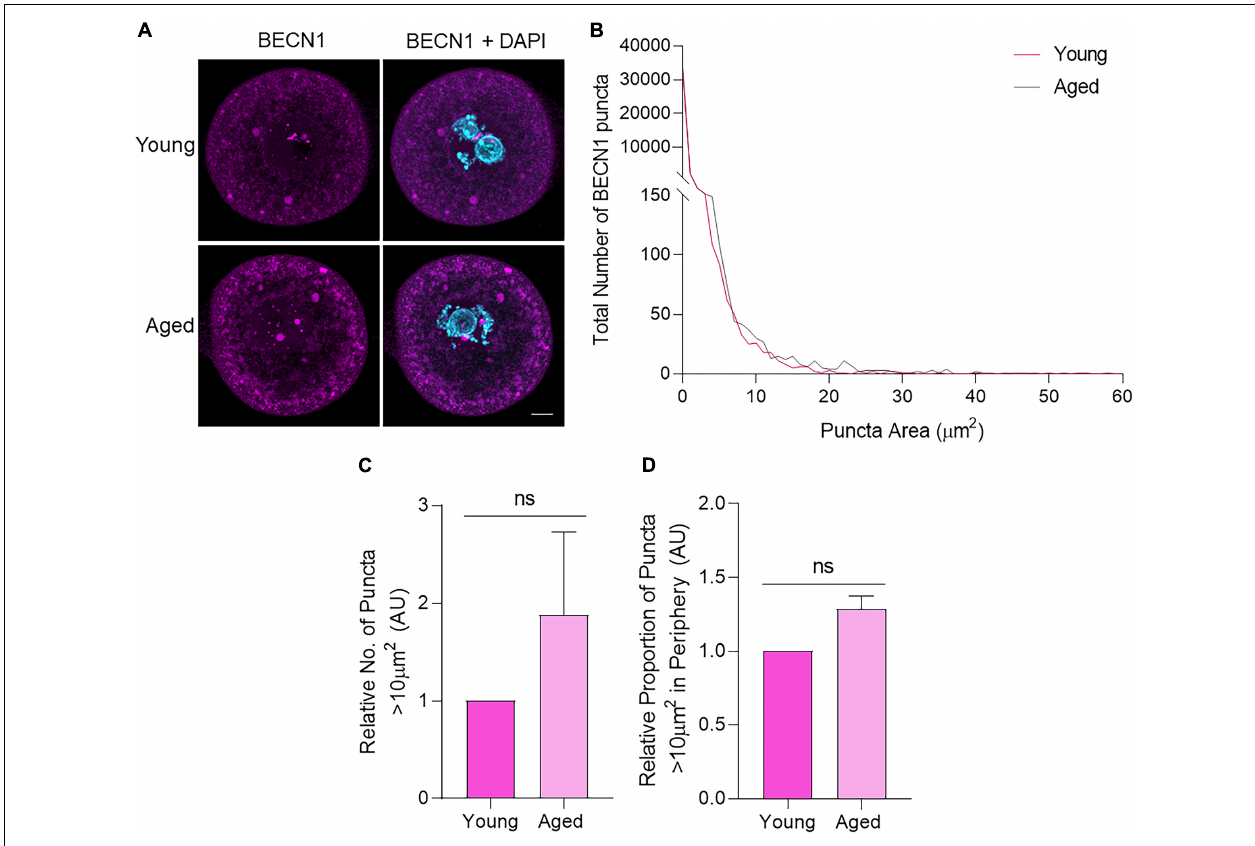
FIGURE 5 | BECN1 protein localization and puncta distribution in young and aged mouse oocytes. Oocytes from young (4–6 weeks old) and aged (12–14 months old) mice were fixed prior to labeling with anti-BECN1 antibodies (pink), nuclear counterstaining with DAPI (cyan), confocal imaging (60 × objective), and puncta analysis. (A) Representative images are presented to illustrate the punctate cytoplasmic and nuclear localization of BECN1 in young and aged oocytes. Scale bar = 10 µ m. (B) Images were assessed for the number and area of BECN1 labeled puncta, and these data were used to graph the size distribution of puncta in populations of young (pink line) and aged oocytes (gray line). (C) Comparison of the number of BECN1 labeled puncta > 10 µ m 2 in young and aged oocytes (normalized to young). (D) Comparison of the proportion of BECN1 labeled puncta > 10 µ m 2 that resided within the periphery (outermost 10 µ m) of the oocyte (normalized to young). N = 3, ns, not